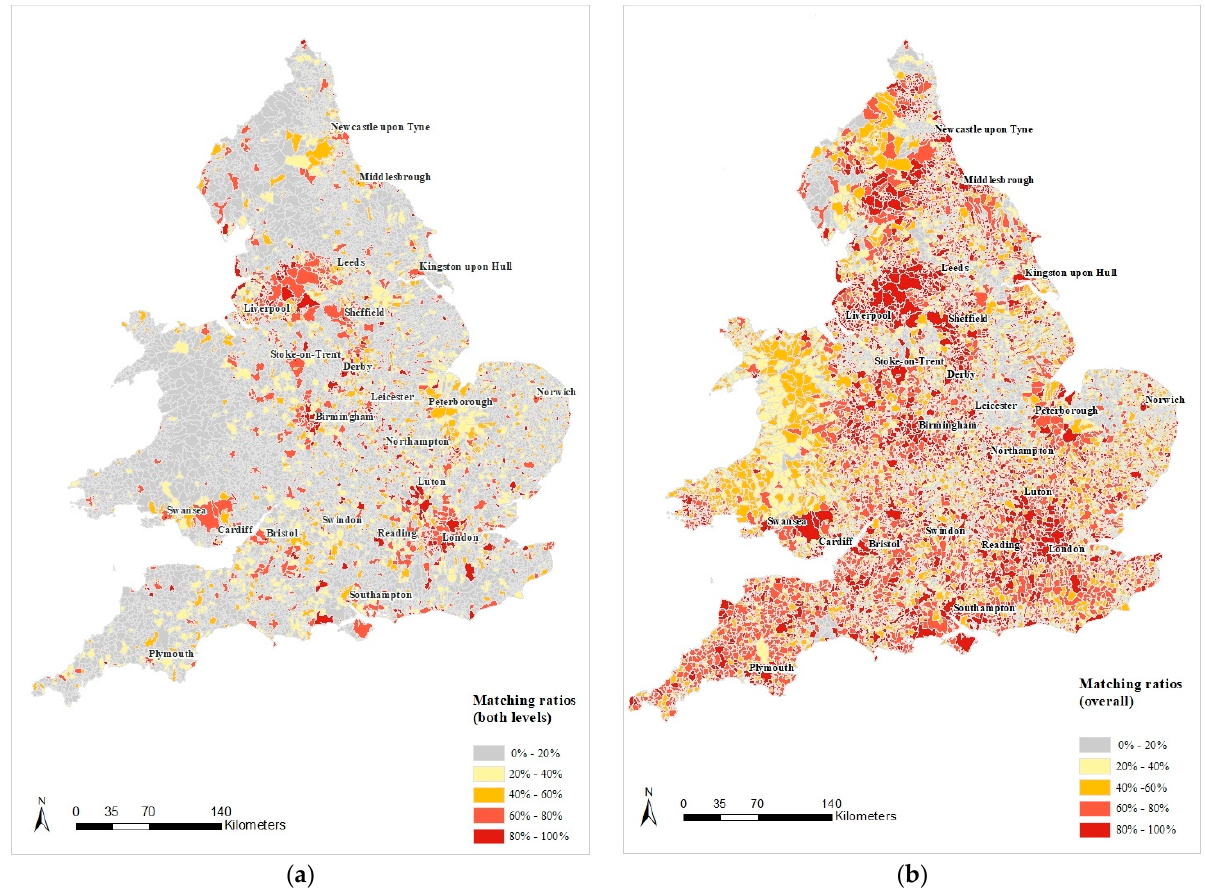
Figure 3. Match rates using AddressBase ( a ), supplemented with the historical gazetteer ( b ) by historical parishes in England and Wales.